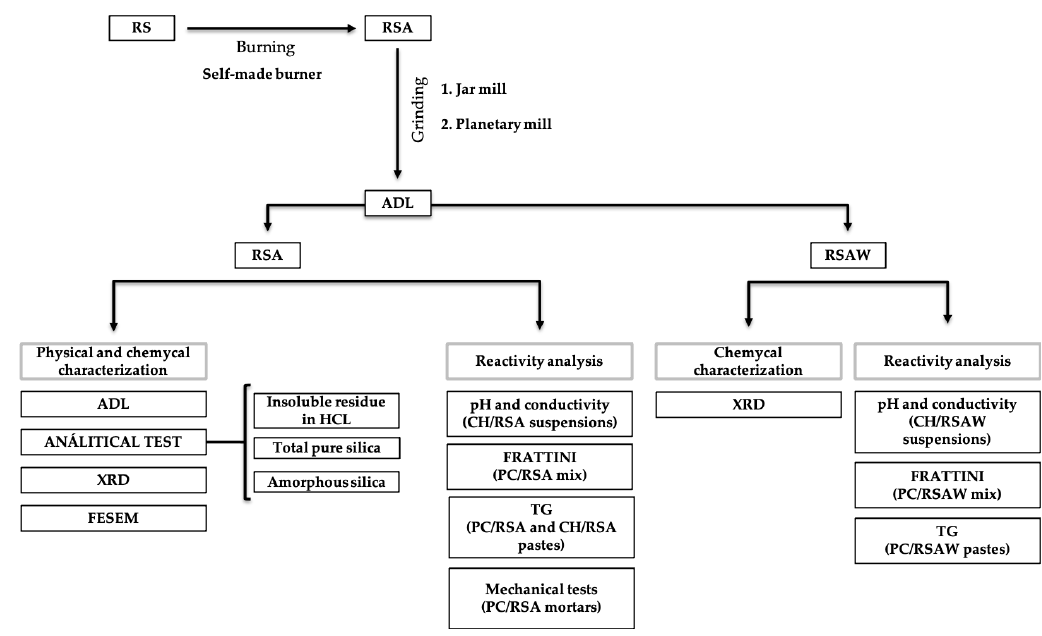
Figure 1. General view of the experimental procedure followed in the present research.